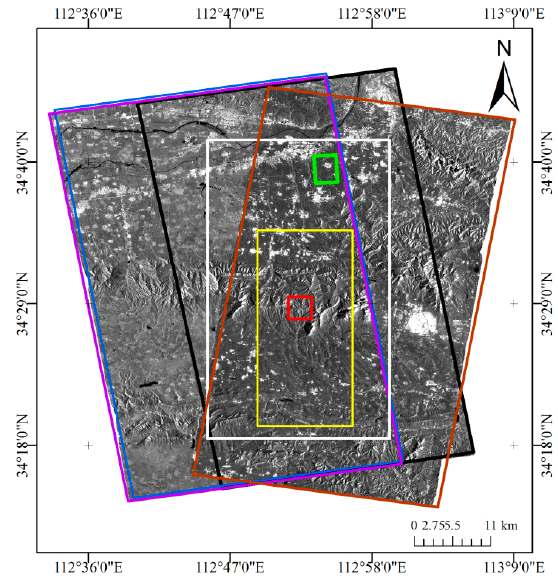
Figure 3. The coverage of the TanDEM-X data is represented by purple (acquired on 19 October 2011 and 26 January 2012), black (20 July 2012), and brown (25 January 2014) rectangles in the georeferenced amplitude images. The photogrammetric DEM is marked by the white rectangle. The green and red rectangles show the plain and mountain sample areas, respectively. The yellow rectangle shows the common coverage area of the InSAR DEMs and reference DEM with different terrain types.